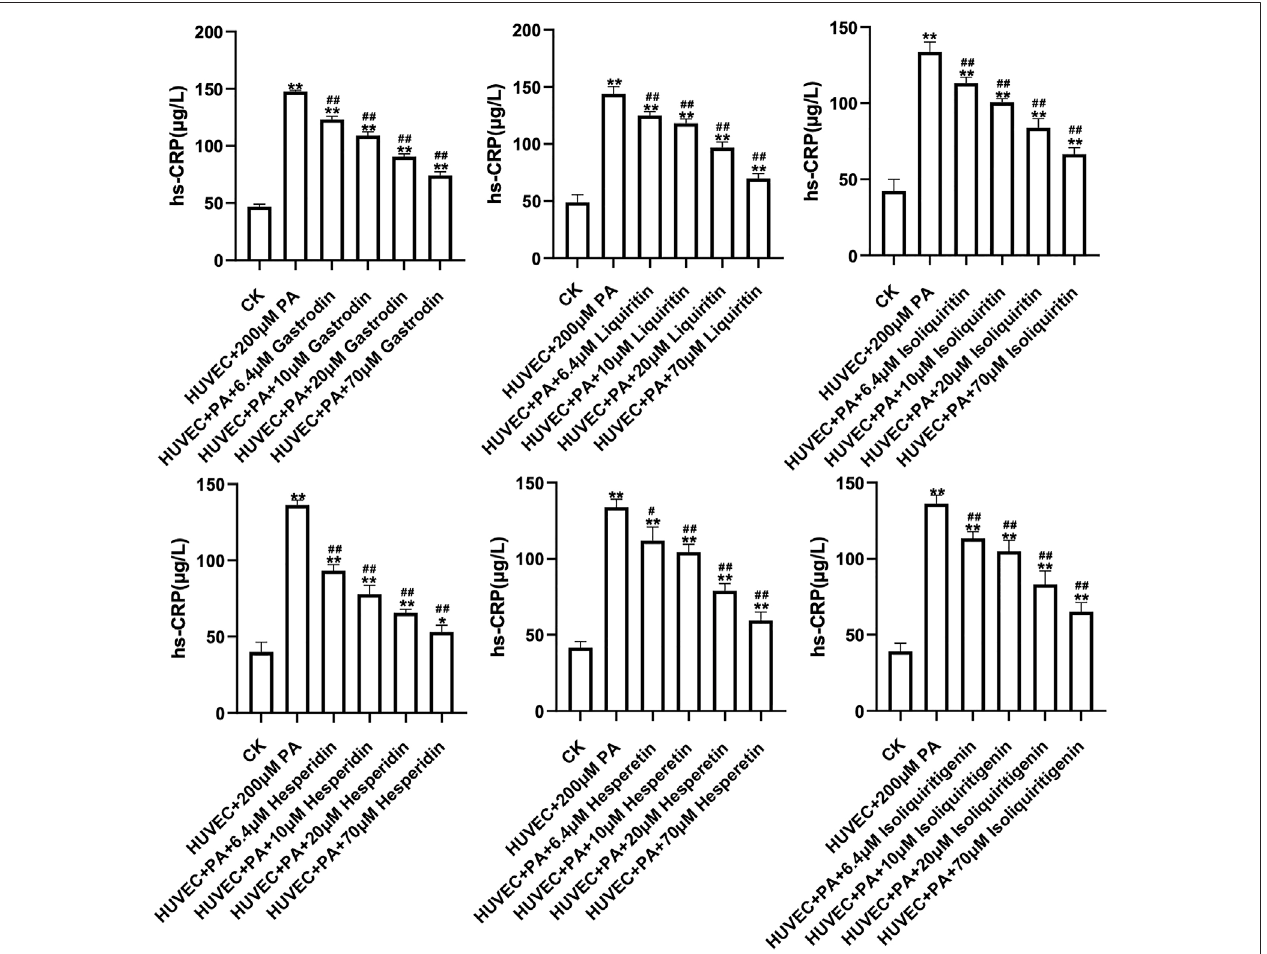
FIGURE 7 | Concentration-response curves of 6 constituents Anti-In fl ammatory effects.